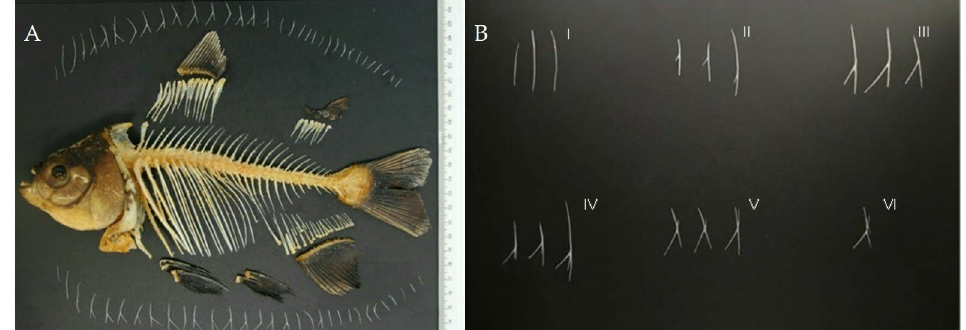
Figure 2. ( A )—Completely dissected specimen with the different small bones organized according to the order of collection. ( B )—Intermuscular bone types (type I = spine without forked; type II = incomplete forked spine; type III = Y-shaped spine; type IV = two-pronged spine type at one end; type V = two-pronged spine type at two ends; type VI = multiple forked spines at both ends).